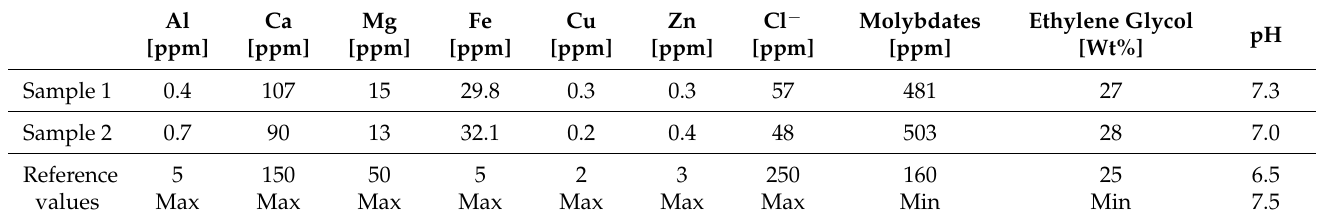
Table 2. Chemical analysis of two samples taken from the solution present inside the cooling Circuit